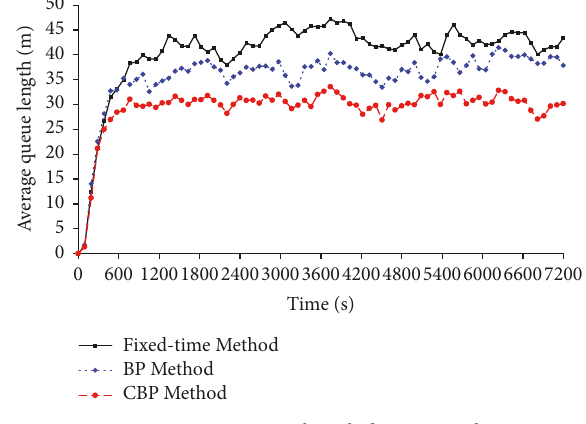
Figure 11: Average queue length during simulation.